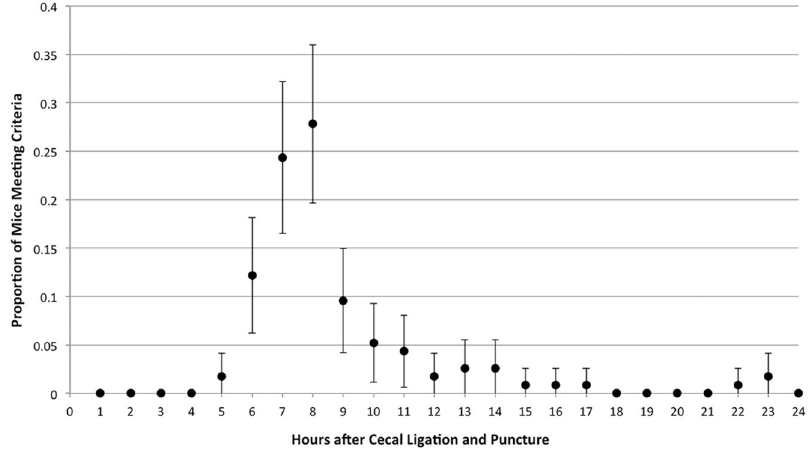
Figure 1. Frequency distribution of mice meeting a threshold of acute physiologic deterioration. The proportion of mice meeting a validated state of acute physiologic deterioration within 30 minutes of each hour after cecal ligation and puncture (n = 115). Data are represented as mean proportion with 95% confidence intervals.